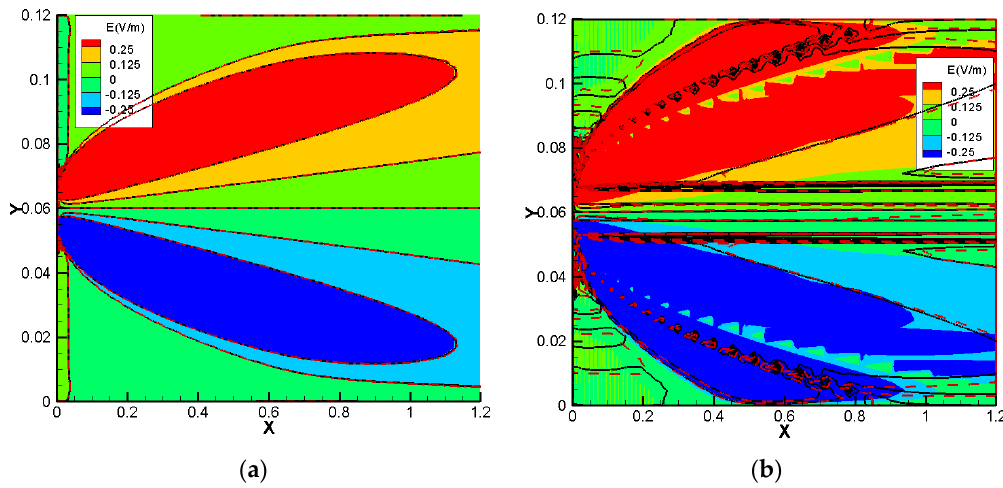
Figure 11. Benchmark3-2D. ( a ) The electric field with the NPP-model for the case of no sorption (colors), low sorption (black lines), and high sorption (red dashed lines). ( b ) The electric field with the NC-model for the case of no sorption (colors), low sorption (black lines), and high sorption (red dashed lines).